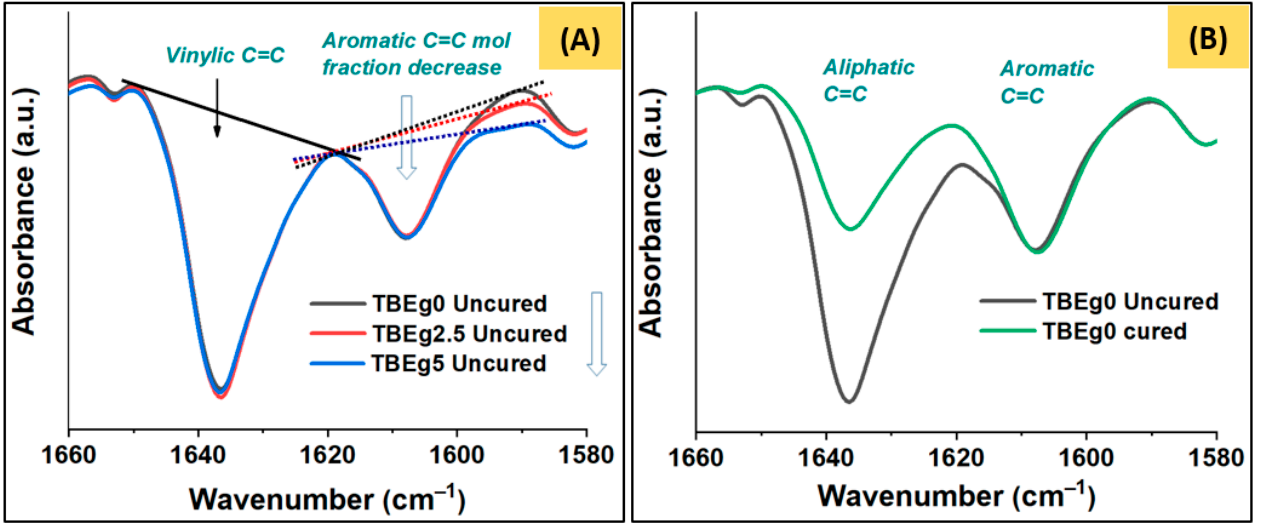
Figure 2. FTIR spectra on the range of C=C absorption (1660–1580 cm − 1 ): ( A ) an illustration of un- cured composites spectra showing the aromatic C=C mole fraction differences and ( B ) a representation of TBEg0 changes in aliphatic C=C due to photopolymerization process. Table 2. Mole ratio between the aliphatic (vinylic) and aromatic C=C bonds calculated theoretically from the composition and experimentally from FTIR spectra. For easy comparison, values were nor- malized to the control (1.00) in both cases.